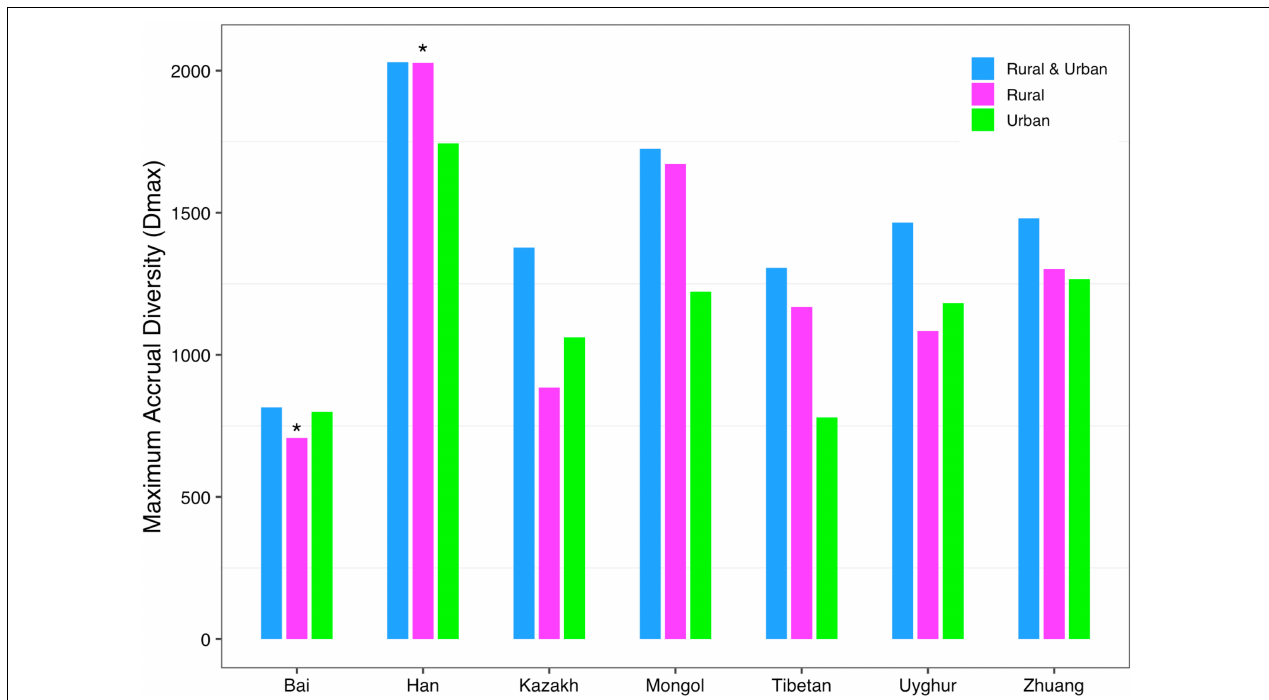
FIGURE 7 | The MAD profiles of all cohorts from Schemes 2A and 2B at the species level when diversity order q = 0 (“*” indicated a significant difference between pairwise comparisons).